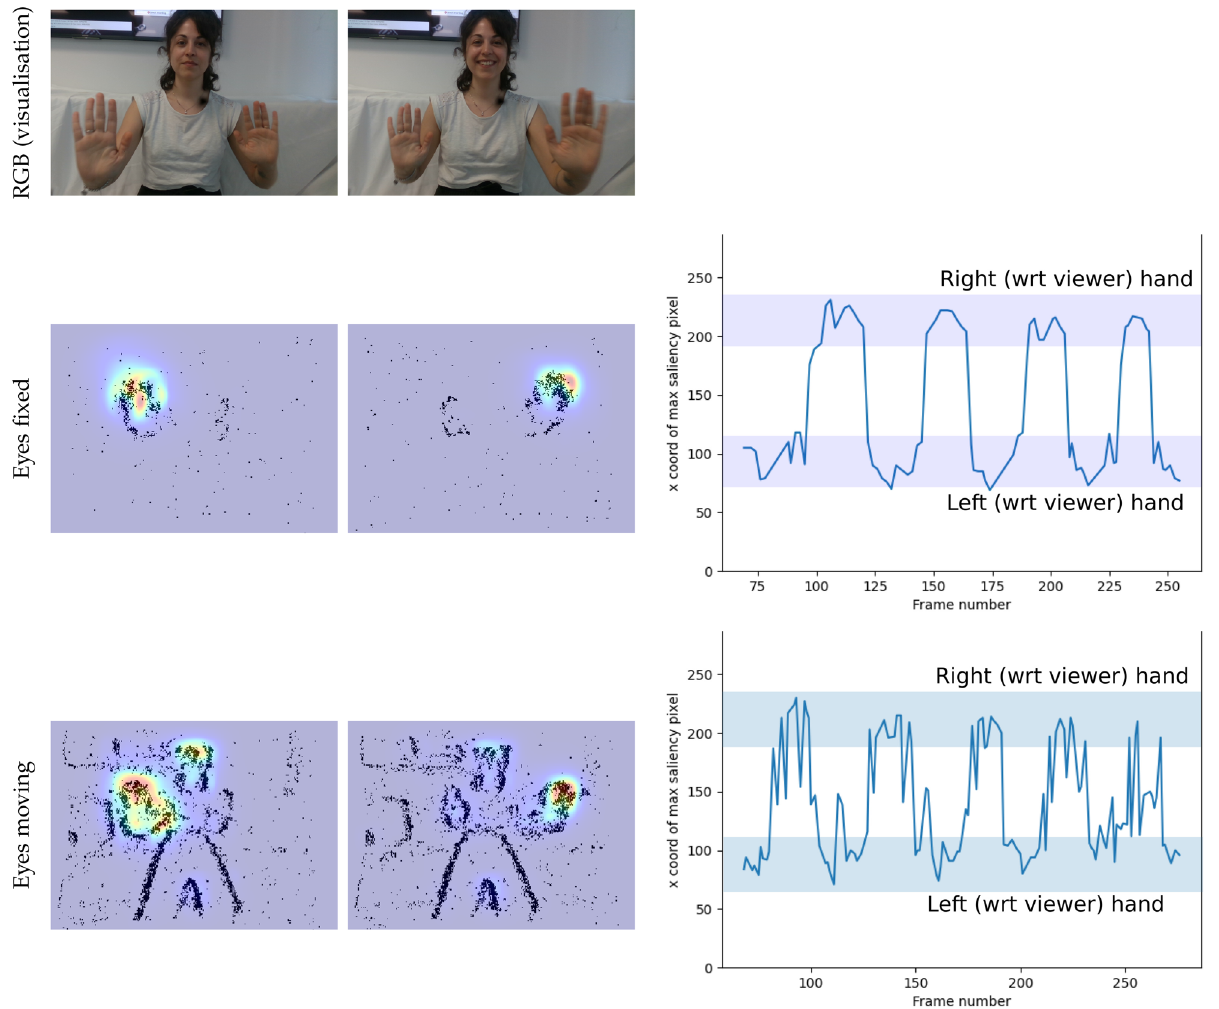
Figure 7. Saliency prediction from evProtoDepth in a dynamic scene (data set hands ) containing hands moving towards the cameras and away from them, with and without the iCub eye motion. The events from the stereo cameras are the only input to our model. RGB (Row 1) frames at different instances of the sequence are shown for visualisation. The two leftmost columns of Rows 2 and 3 depict corresponding saliency outputs overlaid on input events while the robot eyes were fixed (Row 2), and moving (Row 3). With fixed eyes , only the moving hands trigger events, whereas with moving eyes , events are generated by static as well as moving features in the scene, thus both static (e.g. the face) and moving objects (hands) appear salient. The rightmost column shows the x co-ordinates (along the axis between the person and the cameras) of peak saliency plotted against time (frame number) for both datasets. The true locations of the hands are marked with coloured bands. For static cameras (Row 2), the peak saliency pixel consistently alternates between the left and right hand locations as they move towards and away from the camera, i.e., it follows the hand closest to the camera. For moving eyes , (Row 3), excess events caused by micro-saccades result in some spurious saliency peaks at objects like the face despite them being farther away from the